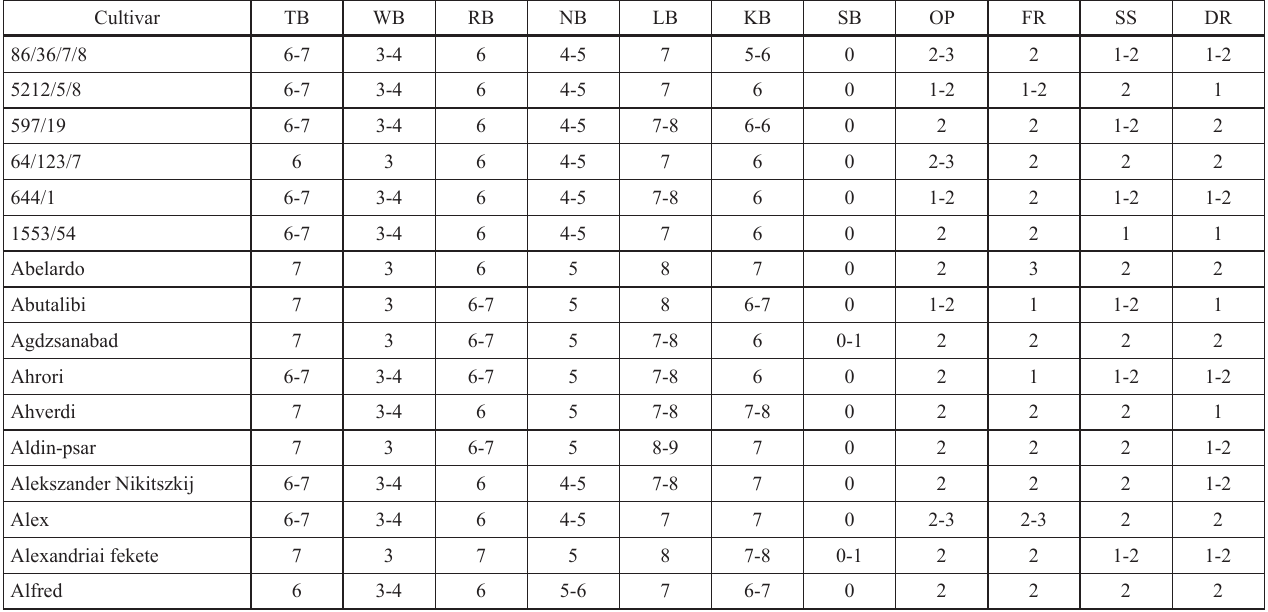
Table 1: Relative ecological and biological indicator values of apricot cultivars